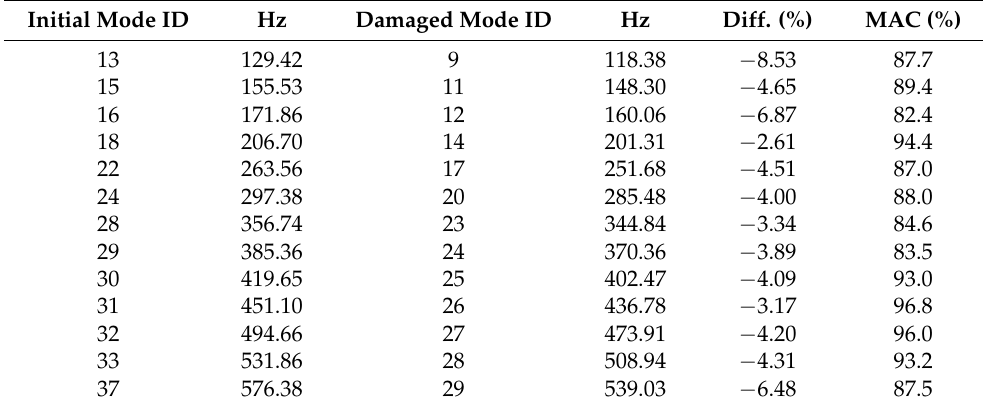
Table 3. List of correlated mode pairs (MAC > 80%), for 250 kN damage